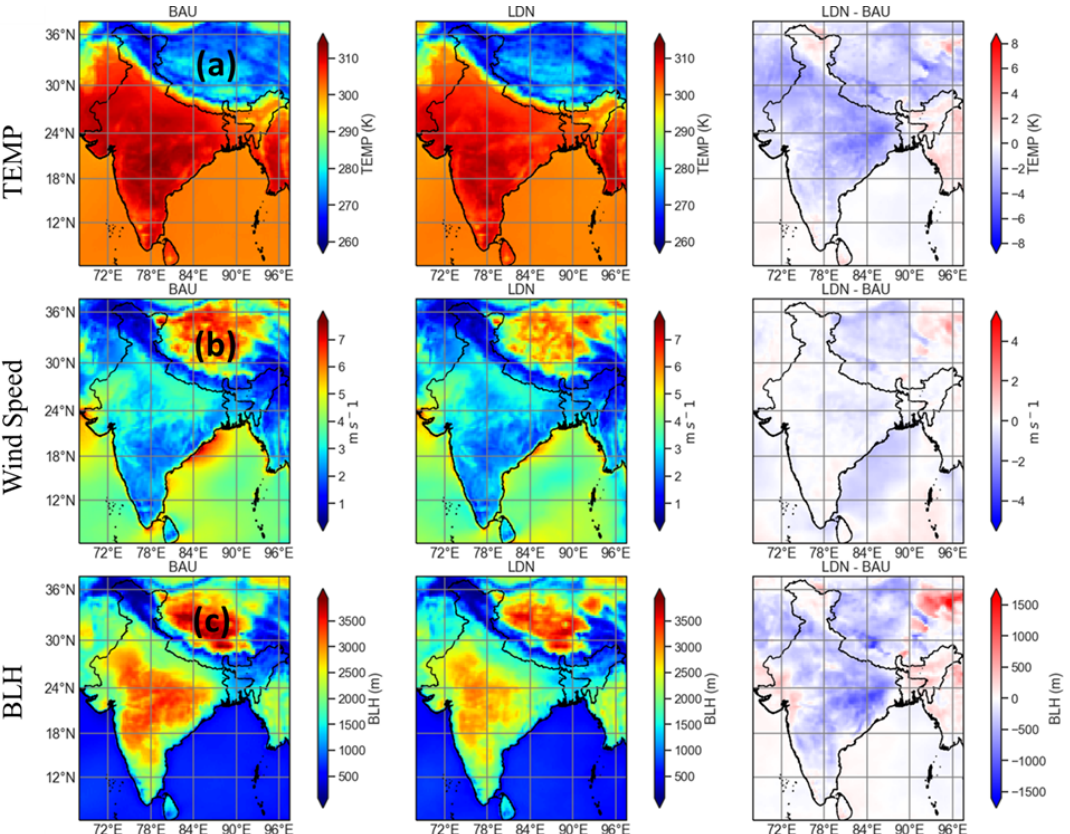
Figure 1. Spatial map showing the variation in surface meteorological parameters ( a temperature, b wind speed, and c BLH) from ERA-5 by comparing BAU (left column), LDN (middle column), and observed difference (LDN − BAU, right column).